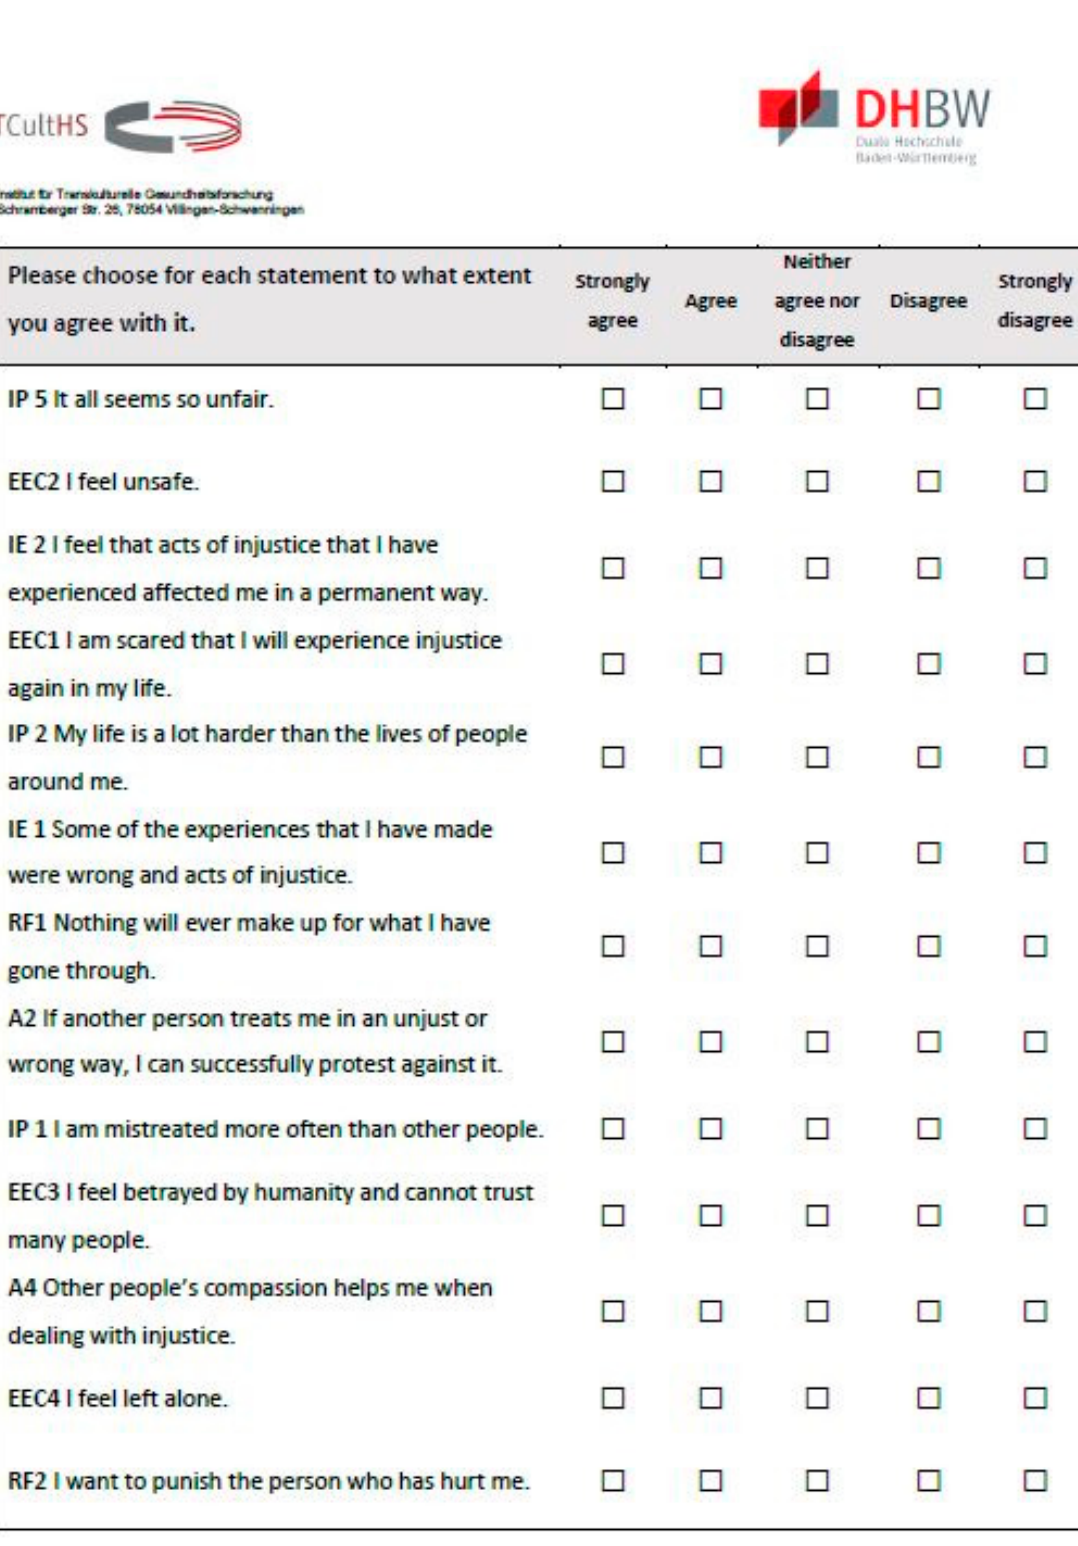
Figure A2. The PIQ, page 2.